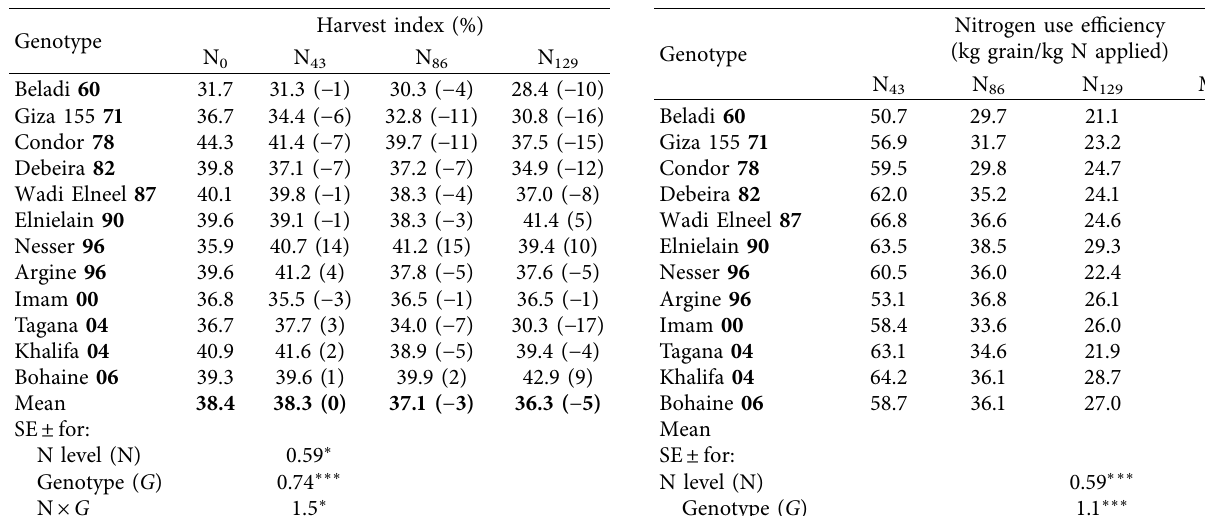
Table 3: Mean harvest index (%) of 12 bread wheat genotypes grown for two seasons under four N levels at Gezira Research Station Farm, Wad Medani, Sudan.